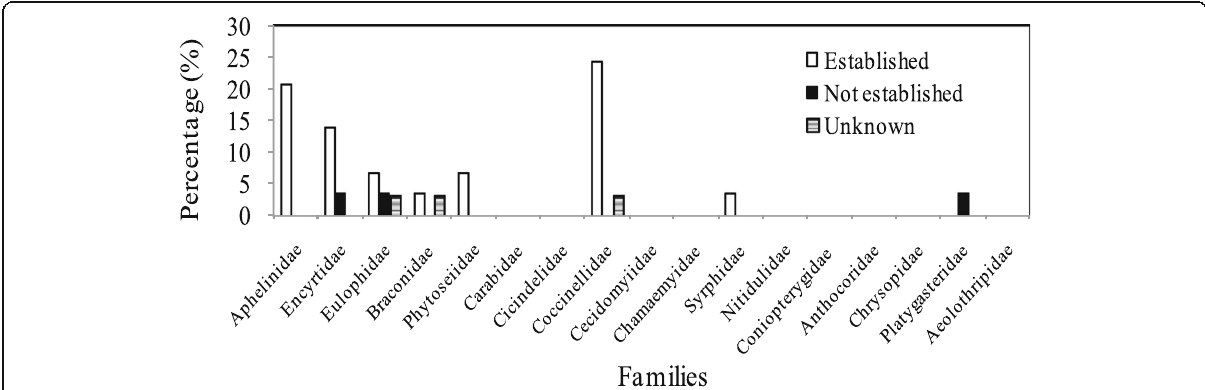
Fig. 4 Percentage of presence (%) of introduced species grouped by families according to their establishment in Moroccan citrus orchard ( N =